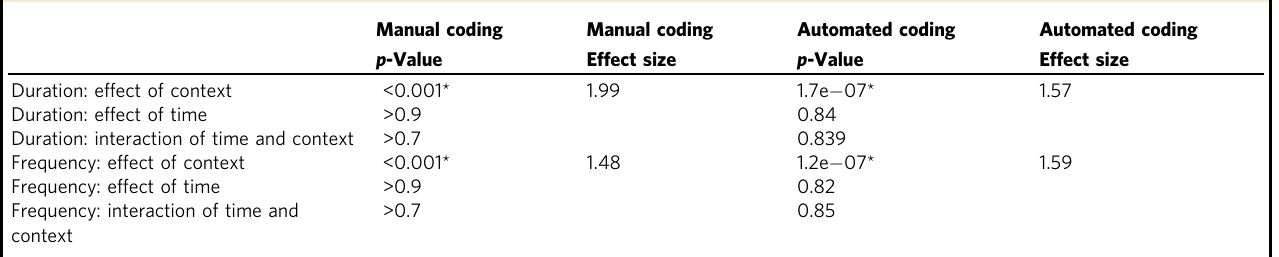
Table 3 Original and reproduced statistical tests of ref. 23